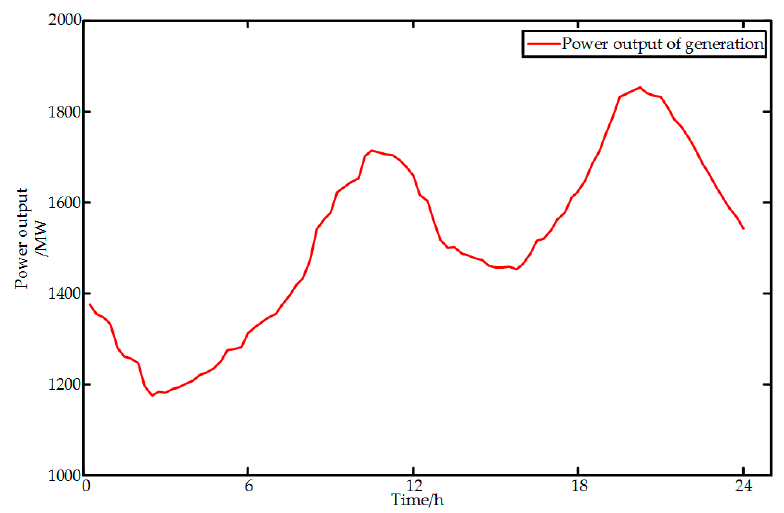
Figure 5. The power output of generation.